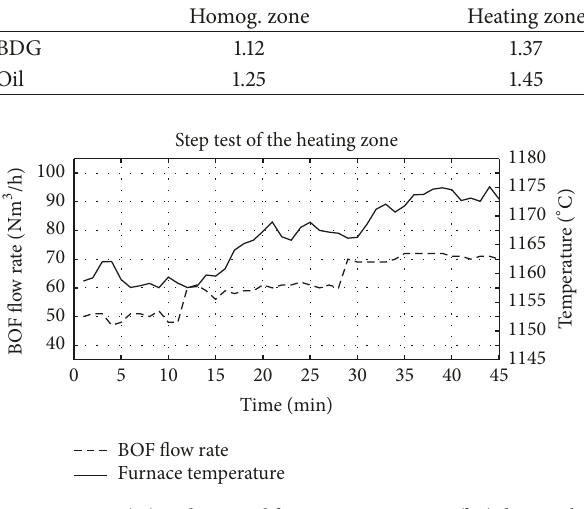
Figure2:BFG(%)andinternalfurnacetemperature( ∘ C)duringthe identification